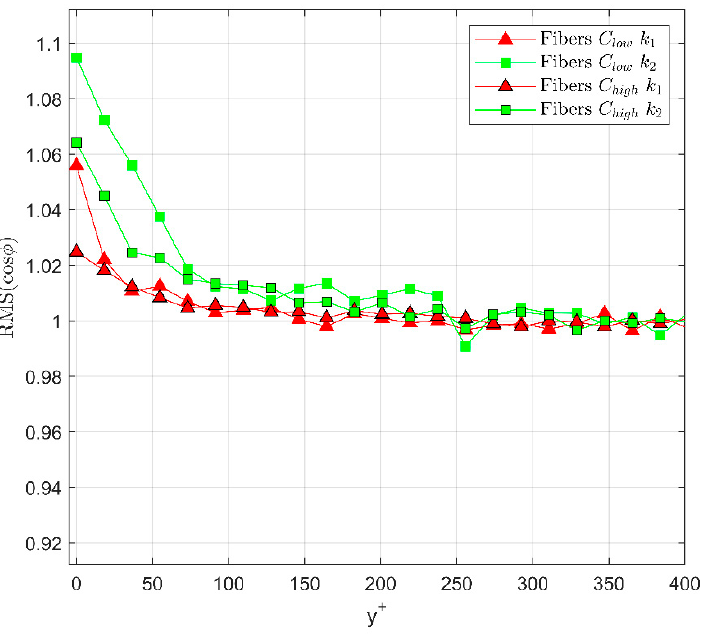
Figure 12. Root mean square (RMS) of fiber orientation angle fluctuations normalized to centerline value.